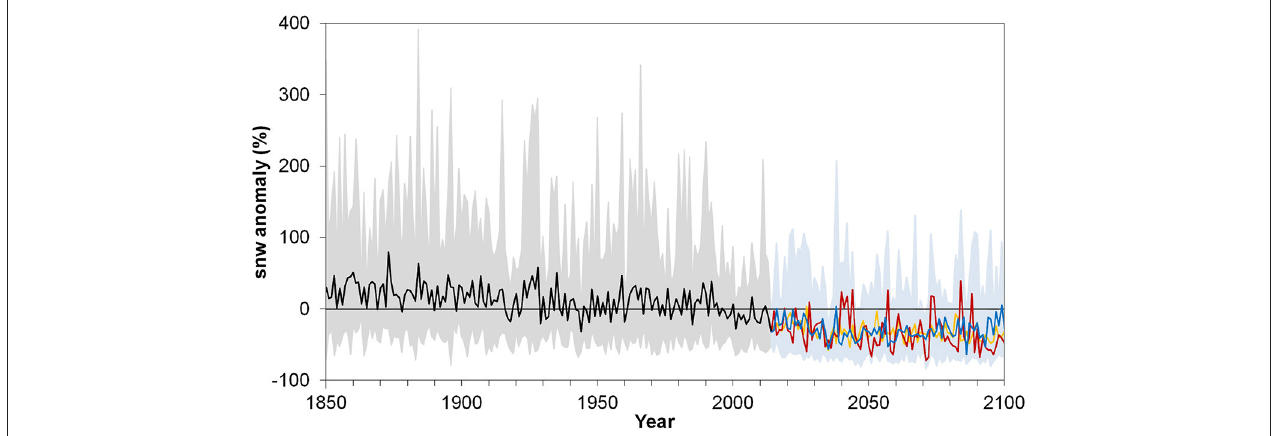
FIGURE 6 | Mean annual variations in surface snow amount (snw) over the Andes region, considering historical (1850–2014) and future (2015–2100) runs of the IPSL-CM6A-LR model, expressed as the percentage of change relative to the 1981–2010 baseline period. The black line represents the ensemble mean for the historical runs, the shading in gray indicates the 5 and 95% quantiles across the historical model runs. The blue, orange, and red lines show the ensemble mean of the future surface runoff projections considering the SSP1-1.9, SSP1-2.6, and SSP4-3.4 scenarios, respectively. The light-blue shading indicates the 5 and 95% quantiles across the future runs.